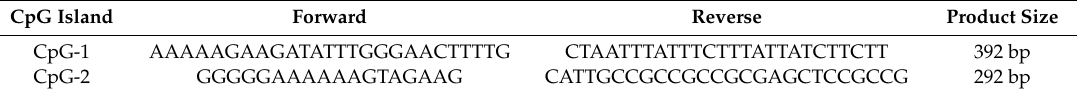
Table 2. Specific primers for CpG island amplification of AcSERK1